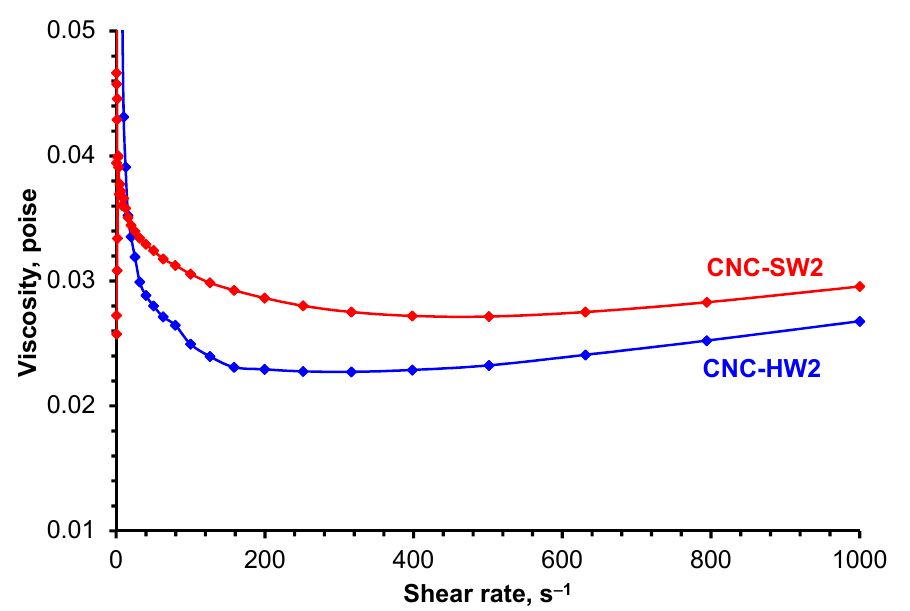
Figure 11. Viscosity comparison of CNC from oxidized HW2 and oxidized SW2.